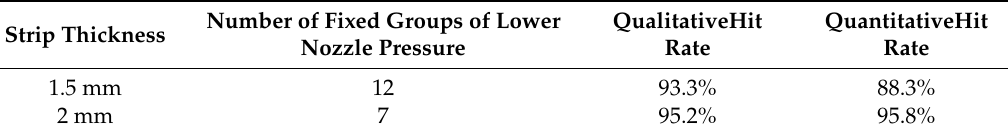
Table 4. Statistics of the model performances in the transition